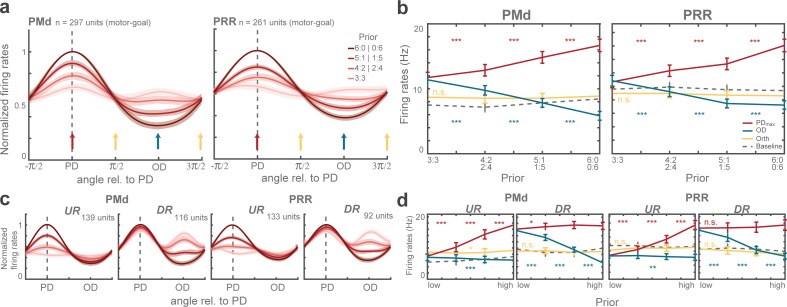
Population tuning functions and graded modulation of motor-goal activities.(a) Average normalized tuning function. Shaded areas correspond to standard errors. Vertical arrows illustrate directions quantified in (b). (b) Comparison of (non-normalized) average firing rates at maximum direction (PDmax: red), opposite direction (OD: blue), orthogonal direction (Orth: yellow) during the planning period (300 ms before the rule-cue onset), and the baseline (gray dotted line) of all motor-goal tuned PMd (left) and PRR (right) neurons. Error bars depict standard errors (*p < αcorr at 5%, **p < αcorr at 1%, ***p < αcorr at 0.1%; Bonferroni-corrected t-test). Interpolated population tunings (a) were plotted for illustrative purposes, in which we refer to interpolated firing rates and PDs continuously between 0° and 360°. Statistical analyses are based on the original neuronal activities restricted to the four discrete directions (0°, 90°, 180°, 270°) which we had sampled in our task as shown in (b). The preferred direction of a neuron was then defined by the direction toward which the motor-goal evoked the maximum response, denoted PDmax. (c–d) Same as (a–b) for upregulating (UR) and downregulating (DR) neurons separately.10.7554/eLife.47581.012Figure 4—source data 1.Average firing rates at PDmax, OD, and Orth directions, along with interpolated tuning curve of each unit.10.7554/eLife.47581.013Figure 4—source data 2.Average firing rates at PDmax, OD, and Orth directions, along with interpolated tuning curve, separately for DR and UR neurons.